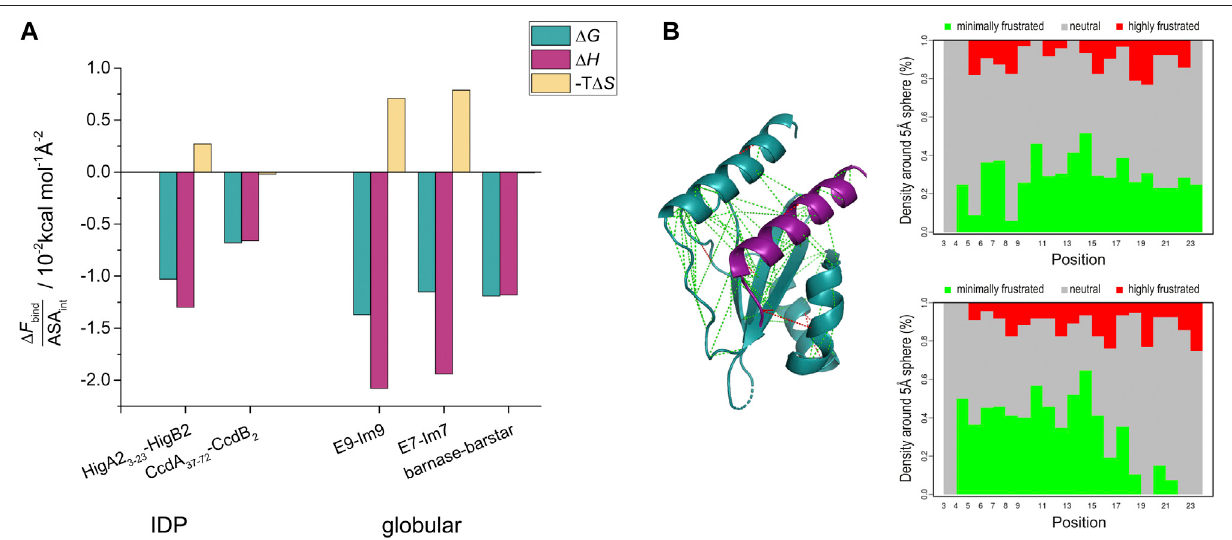
FIGURE 3 | Interaction surface optimization and frustration analysis. (A) The interface surface-area normalized binding contributions ( Δ F bind /ASA int ) of ultra-high af fi nitycomplexesfromIDPs(HigA2 3-23 -HigB2andCcdA 37-72 -CcdB 2 )andfromglobularproteins.Thermodynamicparametersforbinding(foldingissubtractedfromthe overall values in case of IDPs) were normalized per interface surface area (ASA int ) and are shown as bars and reported at T (cid:1) 25 ° C. (B) Frustration index analysis of HigA2 3-23 in complex with the target. Inter-residue interactions are shown on the structure of the HigA2 3-23 -HigB2 complex with lines colored according to frustration index (green no frustration, red frustrated interactions). The values of frustration index for HigA2 3-23 are presented on the right panels: upper shows the conformational frustration index, while the bottom one shows the mutational frustration index (Parra et al.,